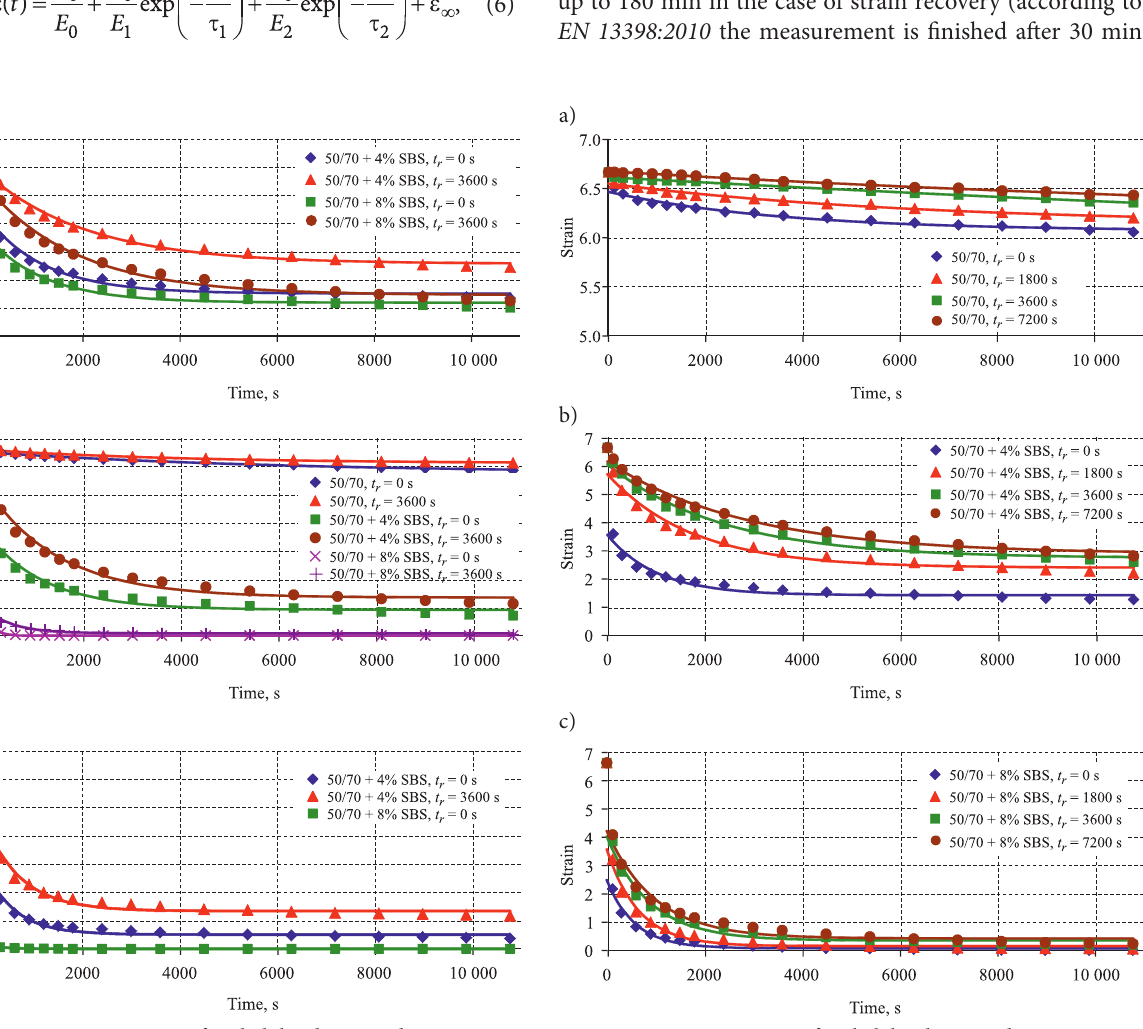
Fig. 3. Inverse creep curves of asphalt binders tested at: Fig. 4. Inverse creep curves of asphalt binders tested at 15 °C: a